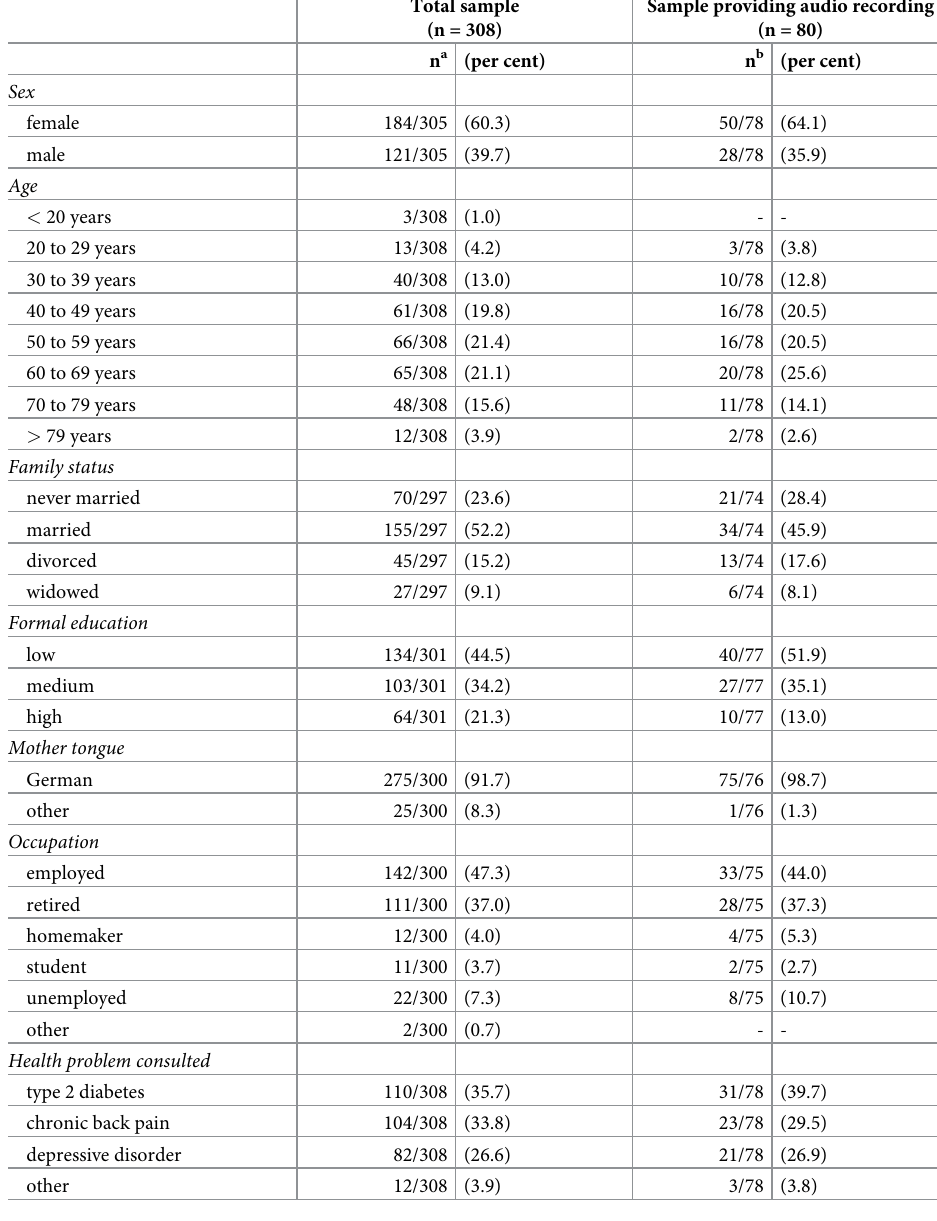
Table 2. Characteristics of participating